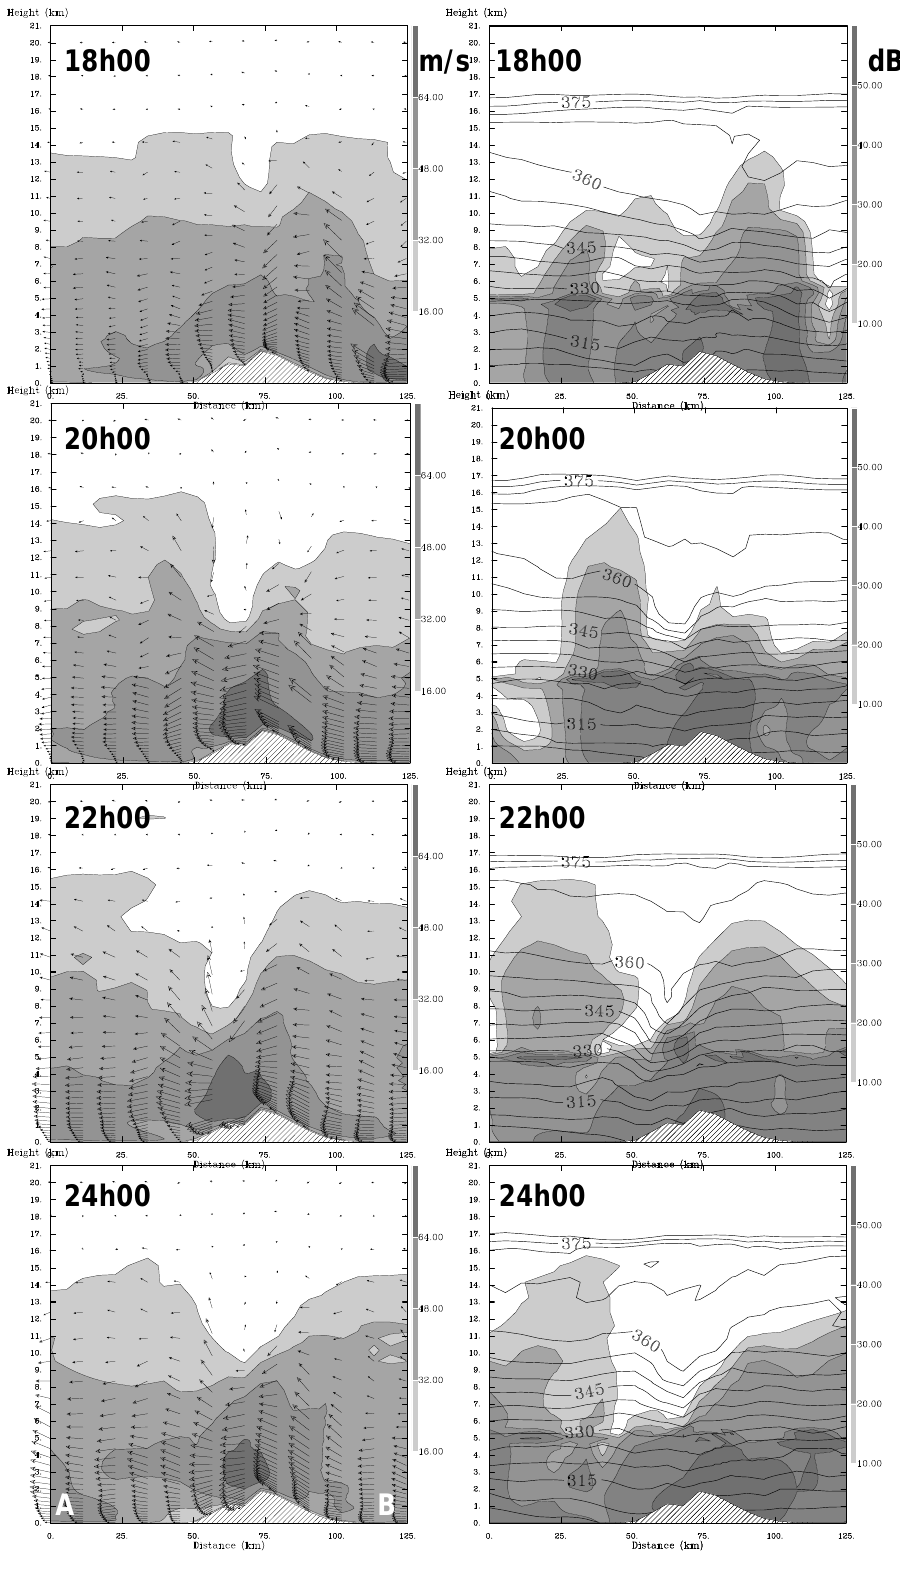
Fig. 13. Left panels: vertical cross-sections of horizontal wind speed (shaded, ms − 1 ) and wind vectors along line AB (see Fig. 12) in the 4-km model of experiment “ Island ”, every 2h from 18 to 24h; right panels: as left panels, except for radar reflectivity (shaded, dBZ) and potential temperature (contours,